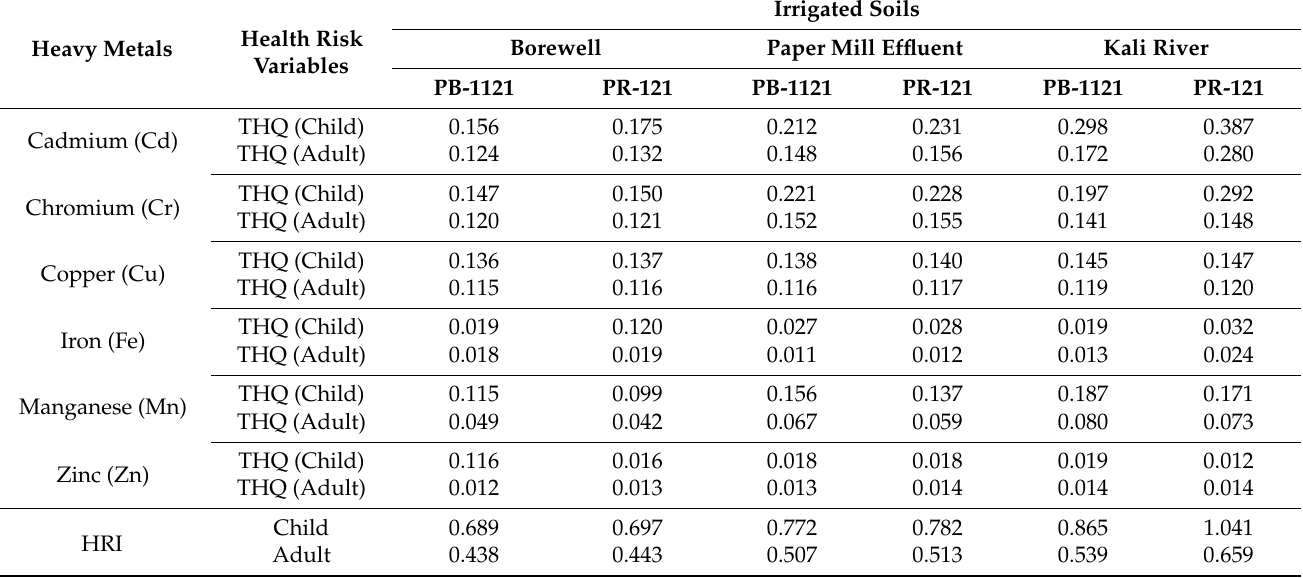
Table 5. Target hazard quotient (THQ)-based health risk assessment of heavy metals accumulation in two rice varieties irrigated with different water